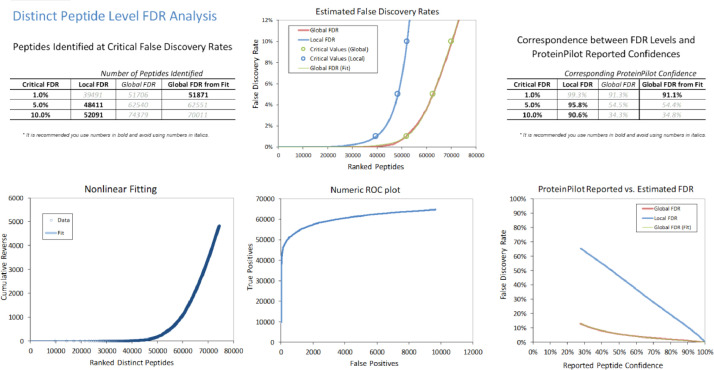
Peptide level FDR analysis of retinal IDA library generated by ProteinPilotTM software for SWATH-MS.